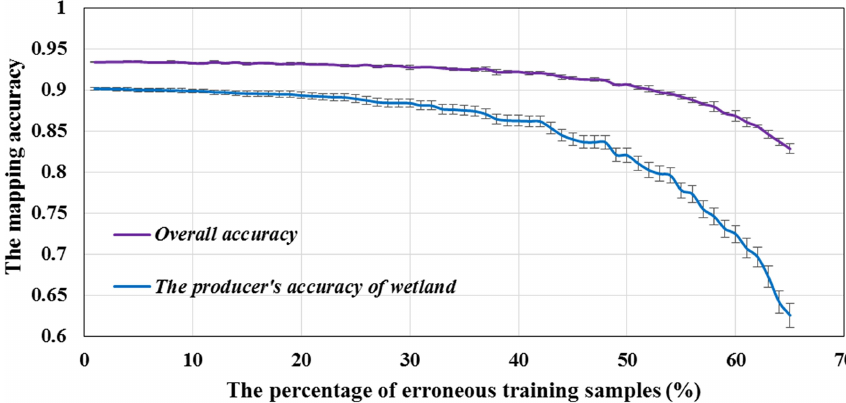
Figure 7. The relationship between mapping accuracies with the percentage of erroneous training samples with a step of